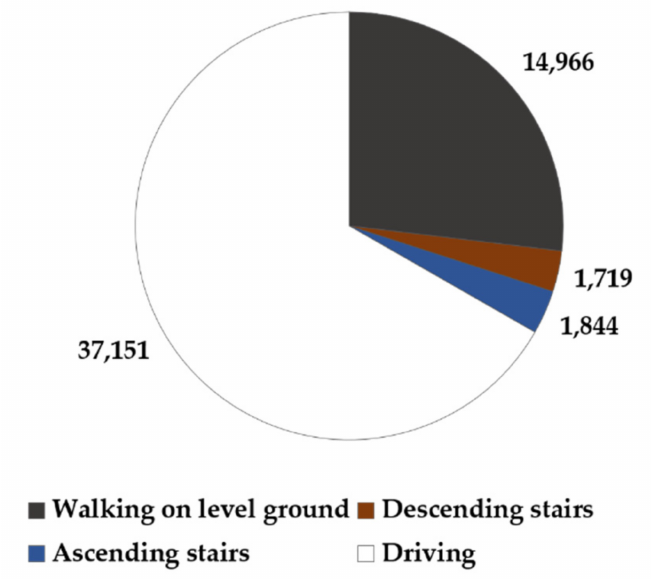
Figure 1. A total number of 5-s epochs in the PA dataset after excluding epochs of transition where two different PAs